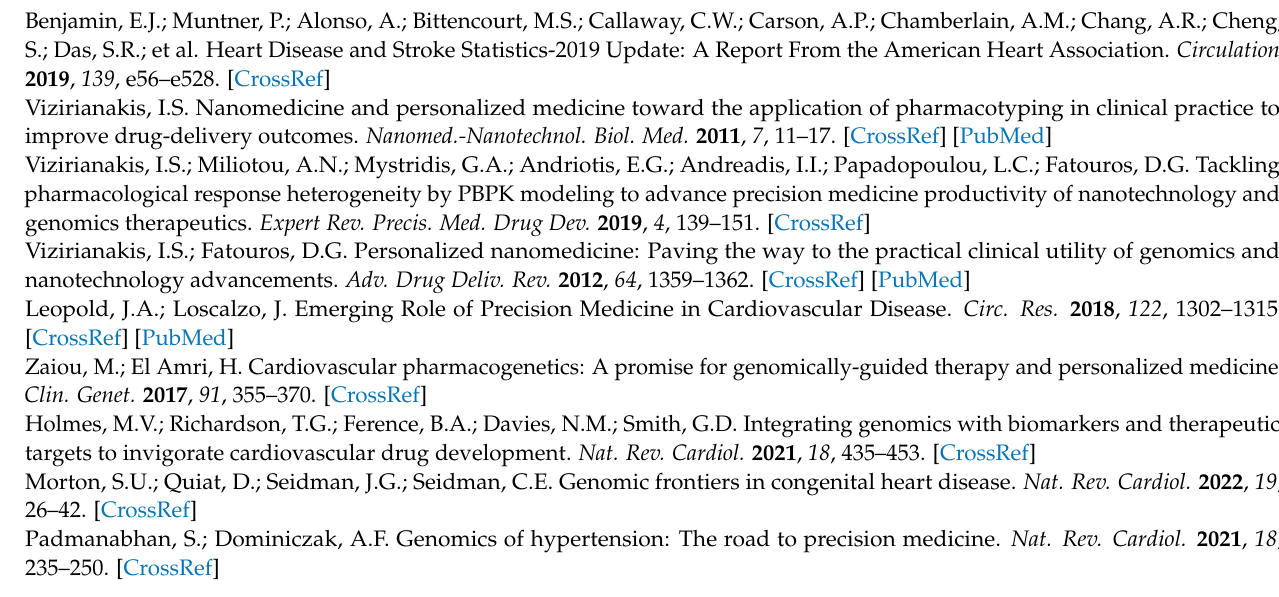
Table S2: DOSE_terms_enrichment_results.xlsx; Table S3: Reactome_pathways_enrichment_results.xlsx; Table S4: List of selected validated target genes (VTGs) with their interacting